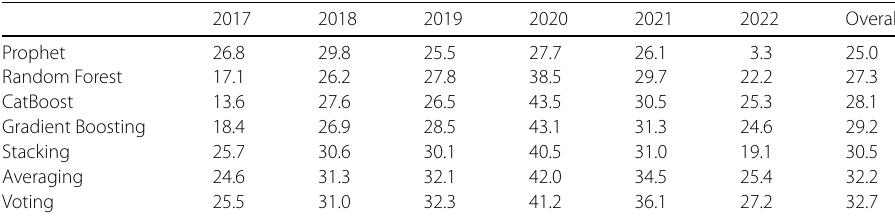
Table 8 Percentage improvement of proposed models over the benchmark for Clinic 1 across all years